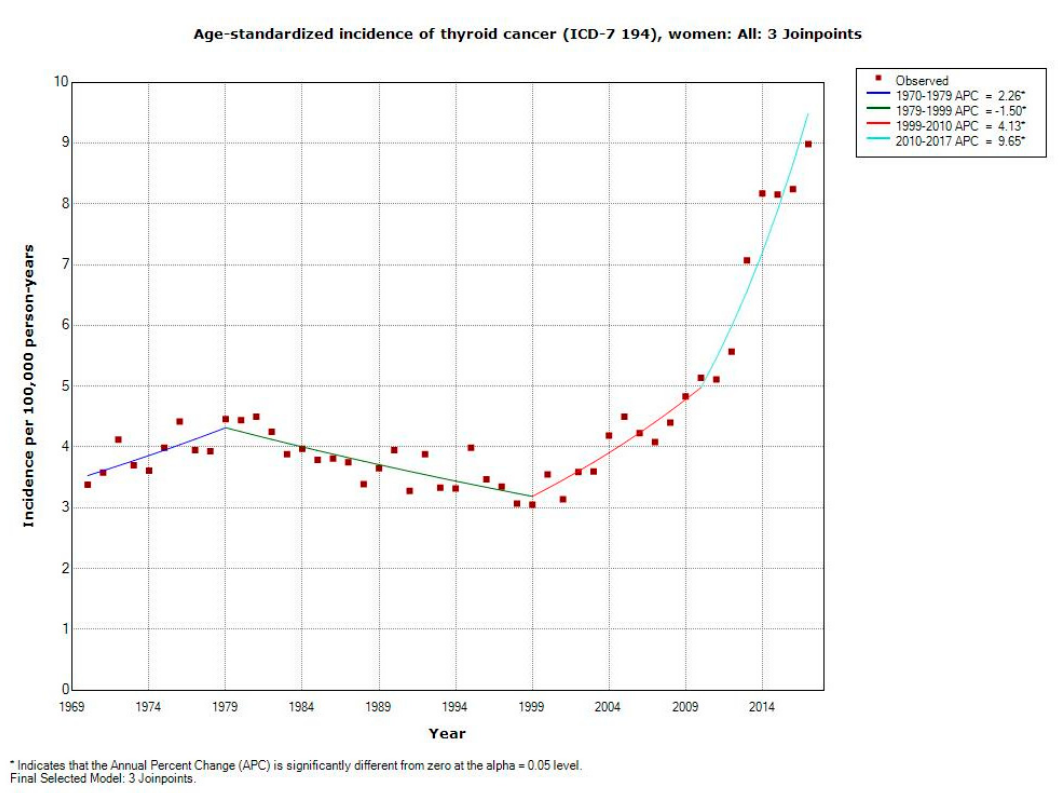
Figure 1. Joinpoint regression analysis of age-standardized incidence of thyroid cancer for women,